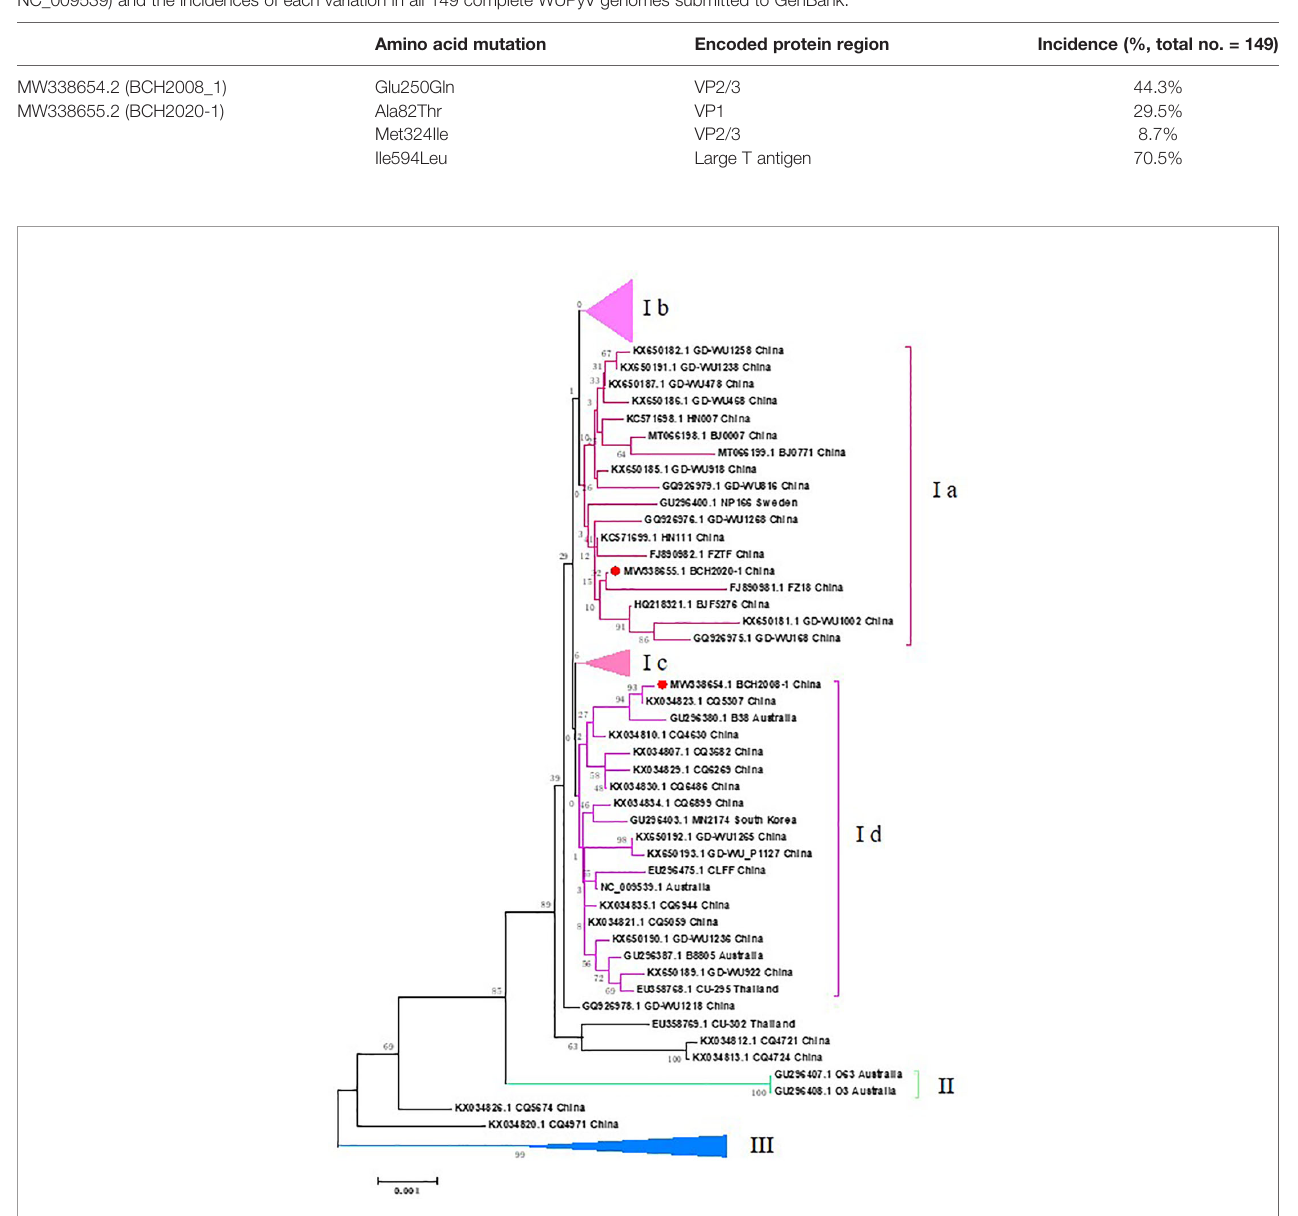
FIGURE 2 | Phylogenetic tree based on the two WUPyV complete genome sequences from fatal cases. Phylogenetic analyses were performed with other 114 WUPyV complete sequences submitted to GenBank, with all sequences derived from China (67 in total) and representative sequences from other countries (23 from Australia, 2 from Thailand, 5 from Germany, 3 from Netherlands, 5 from Canada, 3 from Sweden, 3 from South Korea, and 1 from the USA). MEGA v7.0 software was used to generate phylogenetic trees with the neighbor-joining method and the Kimura 2-parameter model. The robustness of the phylogenetic trees was assessed using the bootstrap method with 1,000 replicates. Reference genomes with bootstrap values below 70 are not shown. The strains in the current study are marked with a solid red